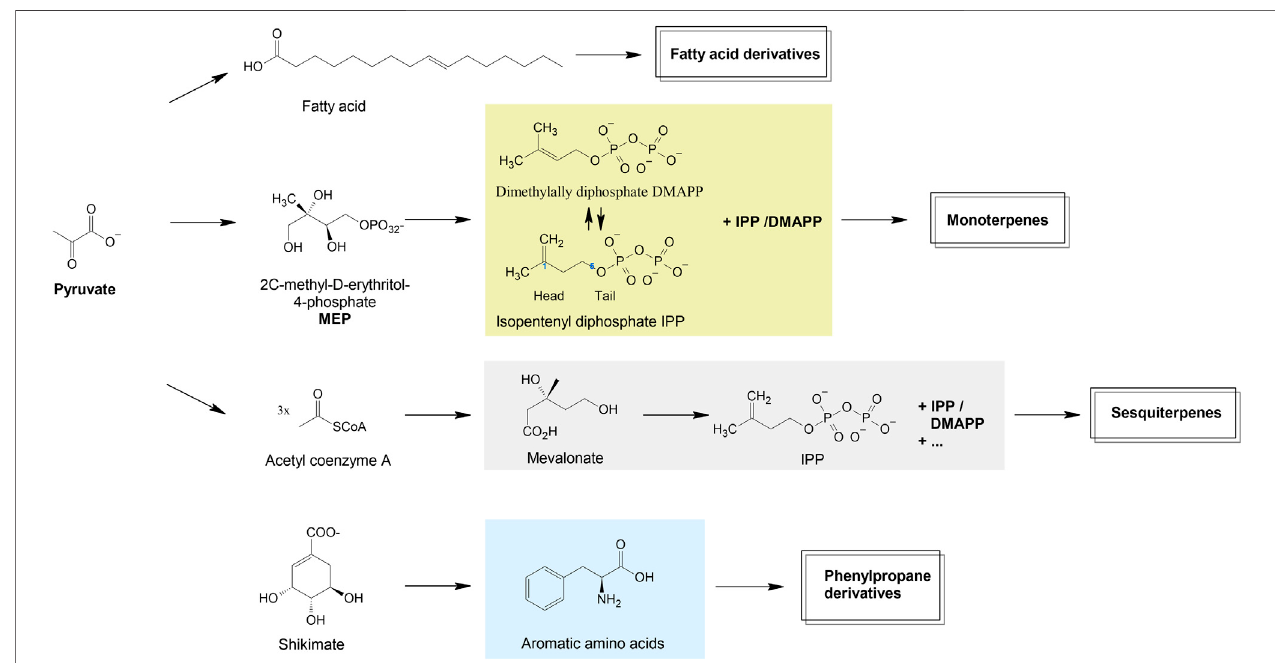
Frontiers in Pharmacology |